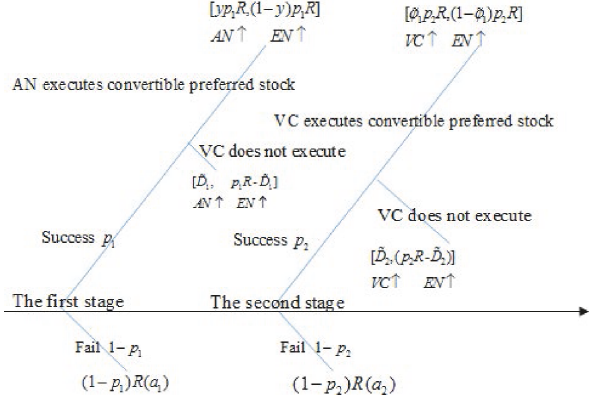
Figure 3: AN does not invest project in the second